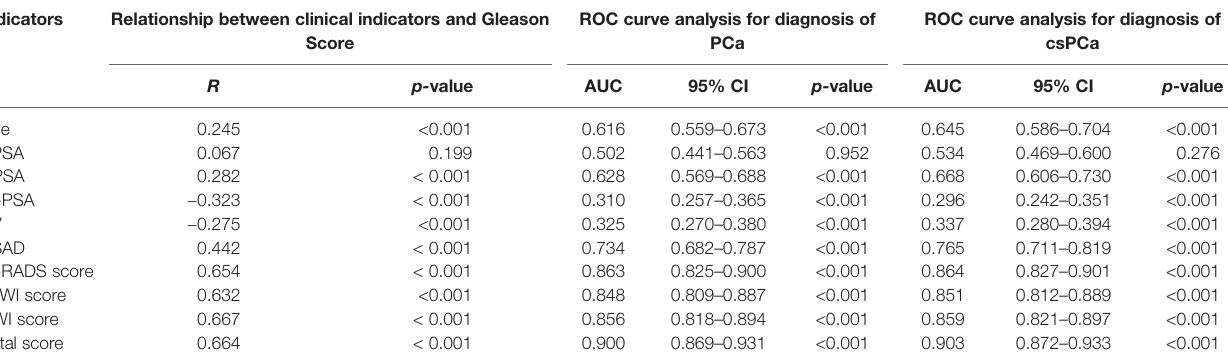
TABLE 2 | Relationship between prebiopsy clinical indicators and Gleason score and evaluating the diagnostic performance of each variable for predicting PCa and csPCa using receiver operating characteristic curve analysis. Indicators